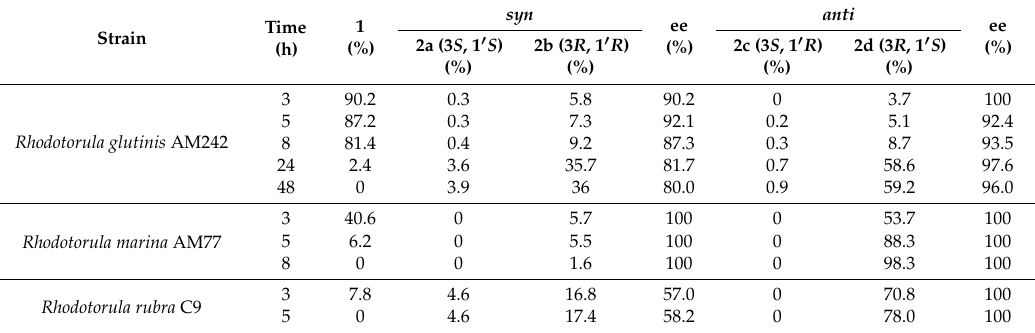
Table 5. The results of biotransformation of α -acetylbutyrolactone 1 in buffer solution (in % according to GC (chiral column)).